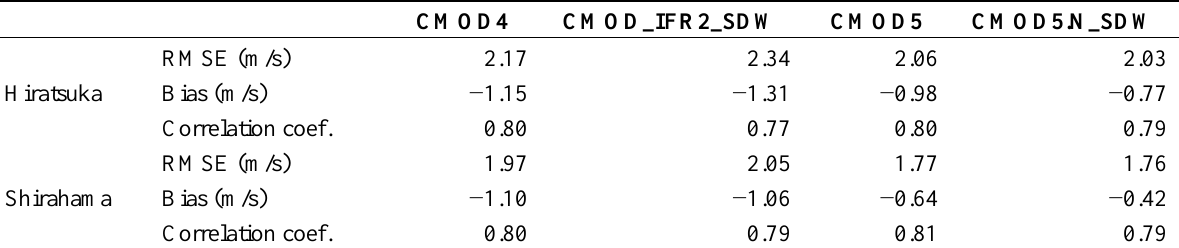
Table 1. RMSEs, biases and correlation coefficients of wind speeds retrieved by four GMFs at both Hiratsuka and